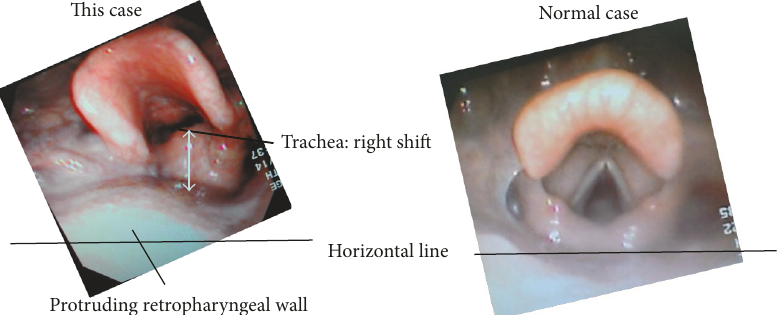
Figure 4: Preoperative laryngeal fibroscopy showing the trachea shifted to the right, and the posterior pharyngeal wall and glottis were pushed